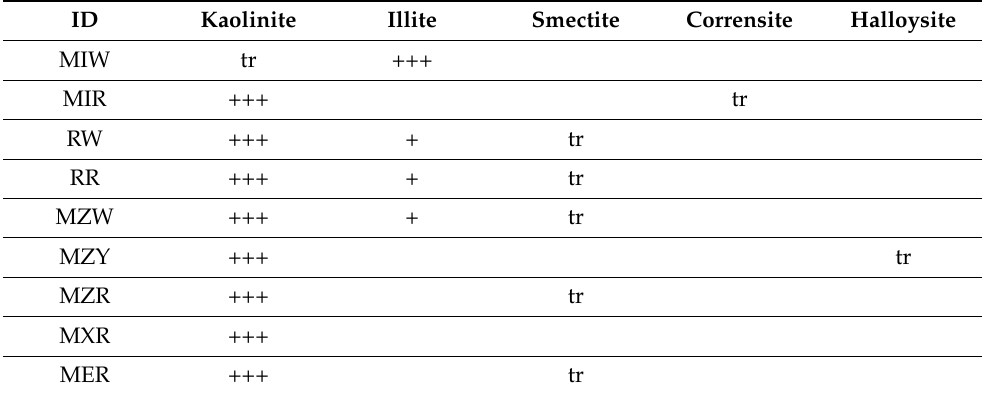
Table 2. Mineralogical composition of clay fraction of studied samples. ID Kaolinite Illite Smectite Corrensite